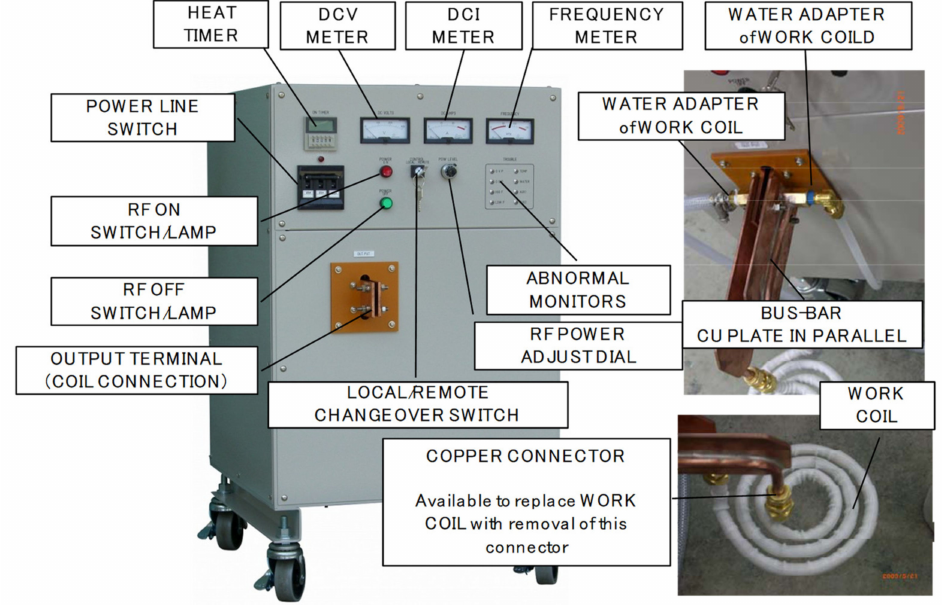
Figure 4. Induction heating unit